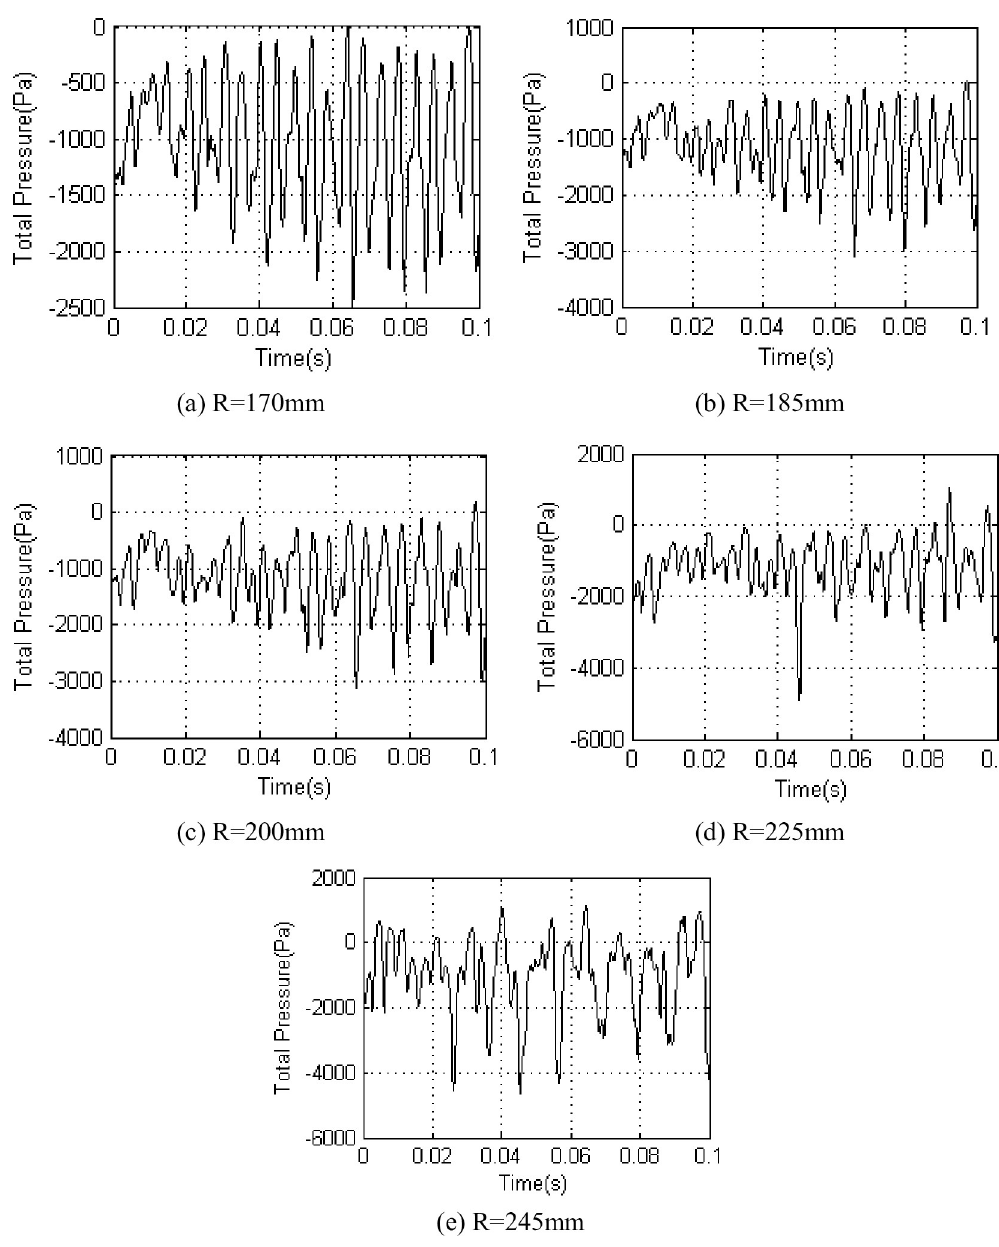
Fig 4. Interstage pressure pulsation on different radius under F =